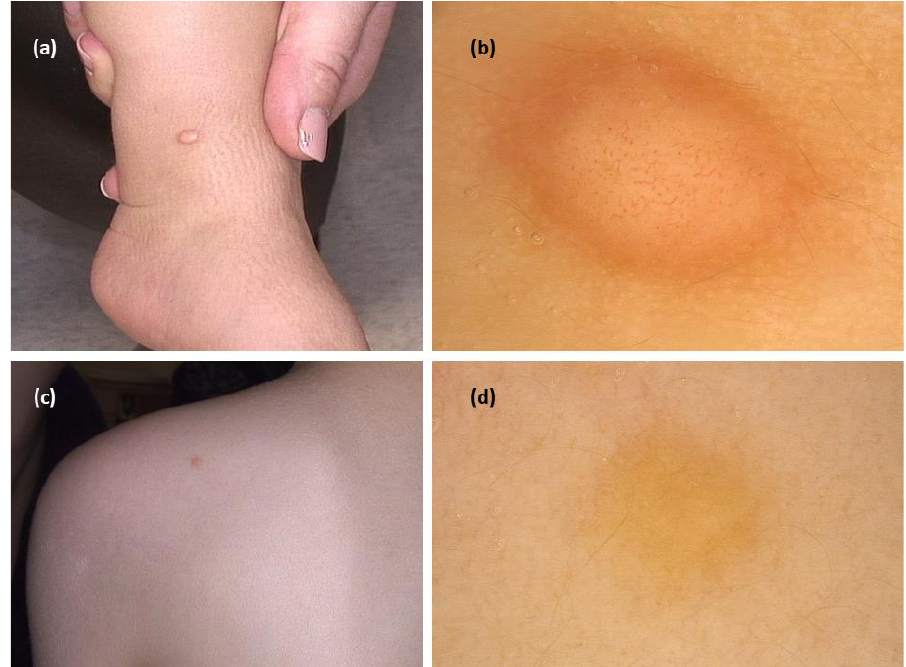
Figure 4. ( a ) Mastocytoma — clinical presentation. ( b ) Dermoscopy shows central polymorphic vessels and peripheral yellow brownish structureless area (FotoFinder, Medicam 800 HD, FotoFinder Systems GmbH, Bad Birnbach, Germany; ×20 magnification, immersion gel). ( c ) Mastocytoma — clinical presentation. ( d ) Dermoscopy shows yellow structureless pattern (FotoFinder, Medicam 800 HD, FotoFinder Systems GmbH, Bad Birnbach, Germany; × 20 magnification, immersion